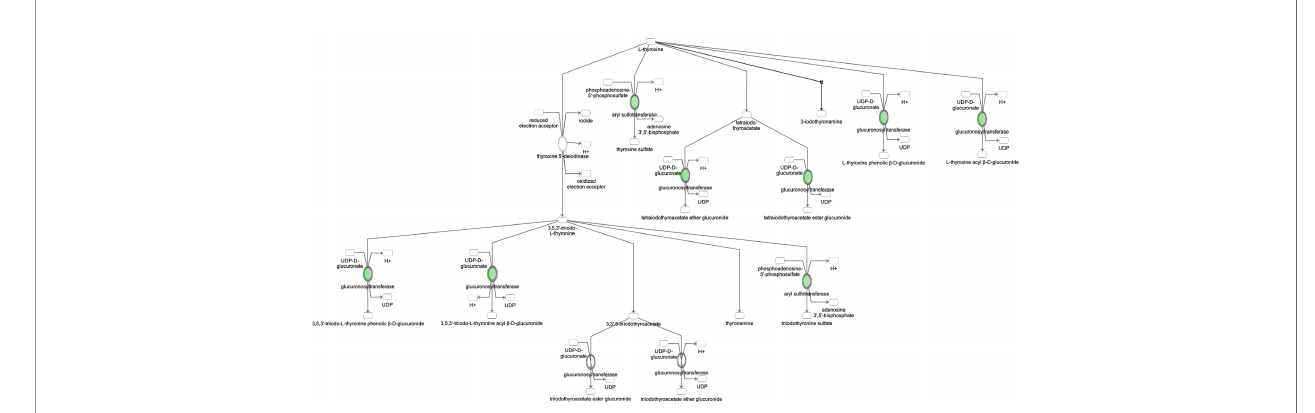
FIGURE 5 | Ingenuity Pathway Analysis of DEPs between FGR vs. Control group. Inhibition of thyroid hormone metabolism. (z = -2.0, p = 4.6e-3) .